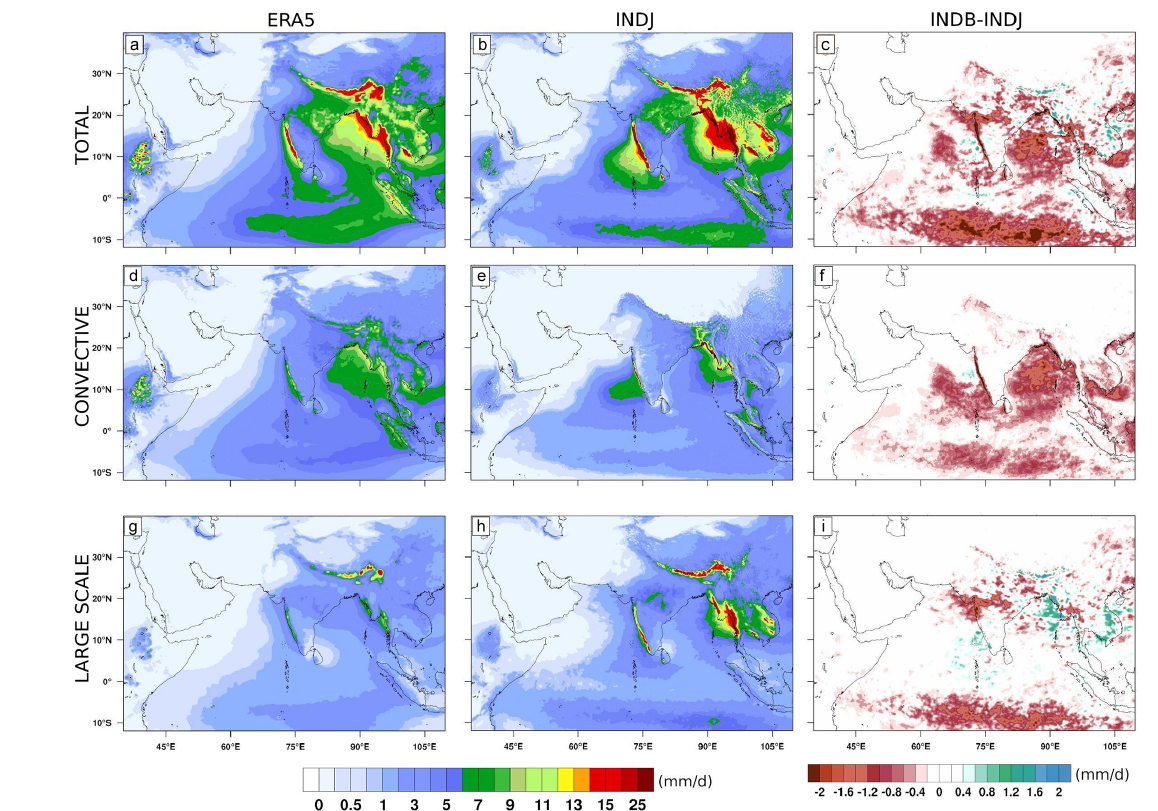
Figure 15. JJAS precipitation for ERA5 ( a , d , g ), INDJ experiment ( b , e , h ), and the differences between INDB and INDJ ( c , f , i ) for total precipitation ( a – c ), convective precipitation ( d – f ) and large-scale precipitation ( g – i ).